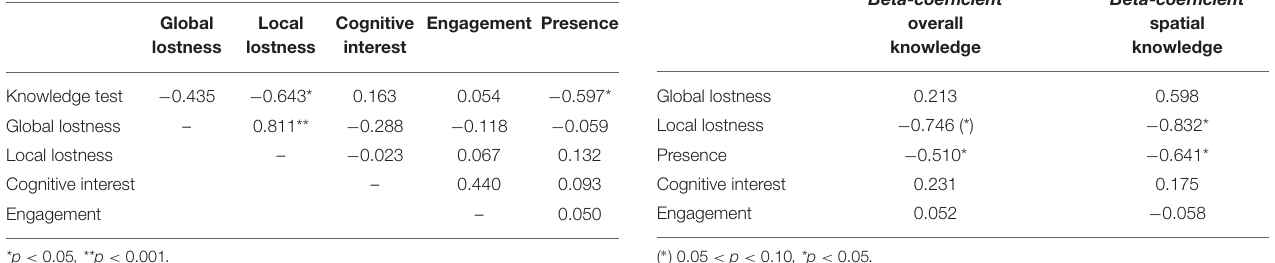
TABLE 3 | Zero-order correlations between knowledge, lostness, and experience measures from the first study.